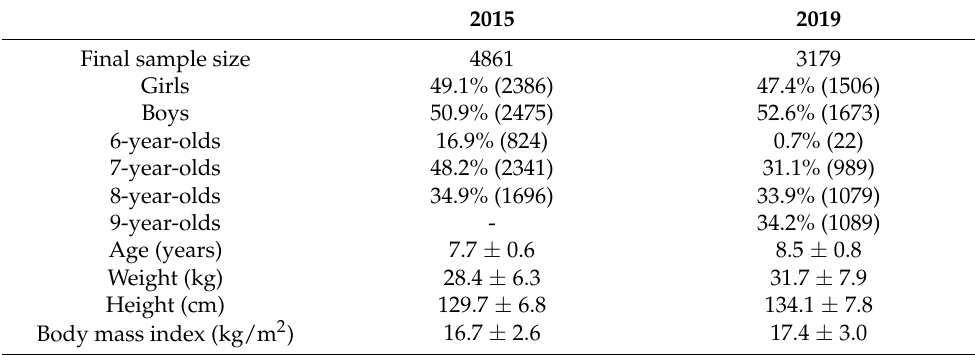
Table 1. Basic characteristics of the final samples in Serbian COSI 2015 and 2019 rounds.